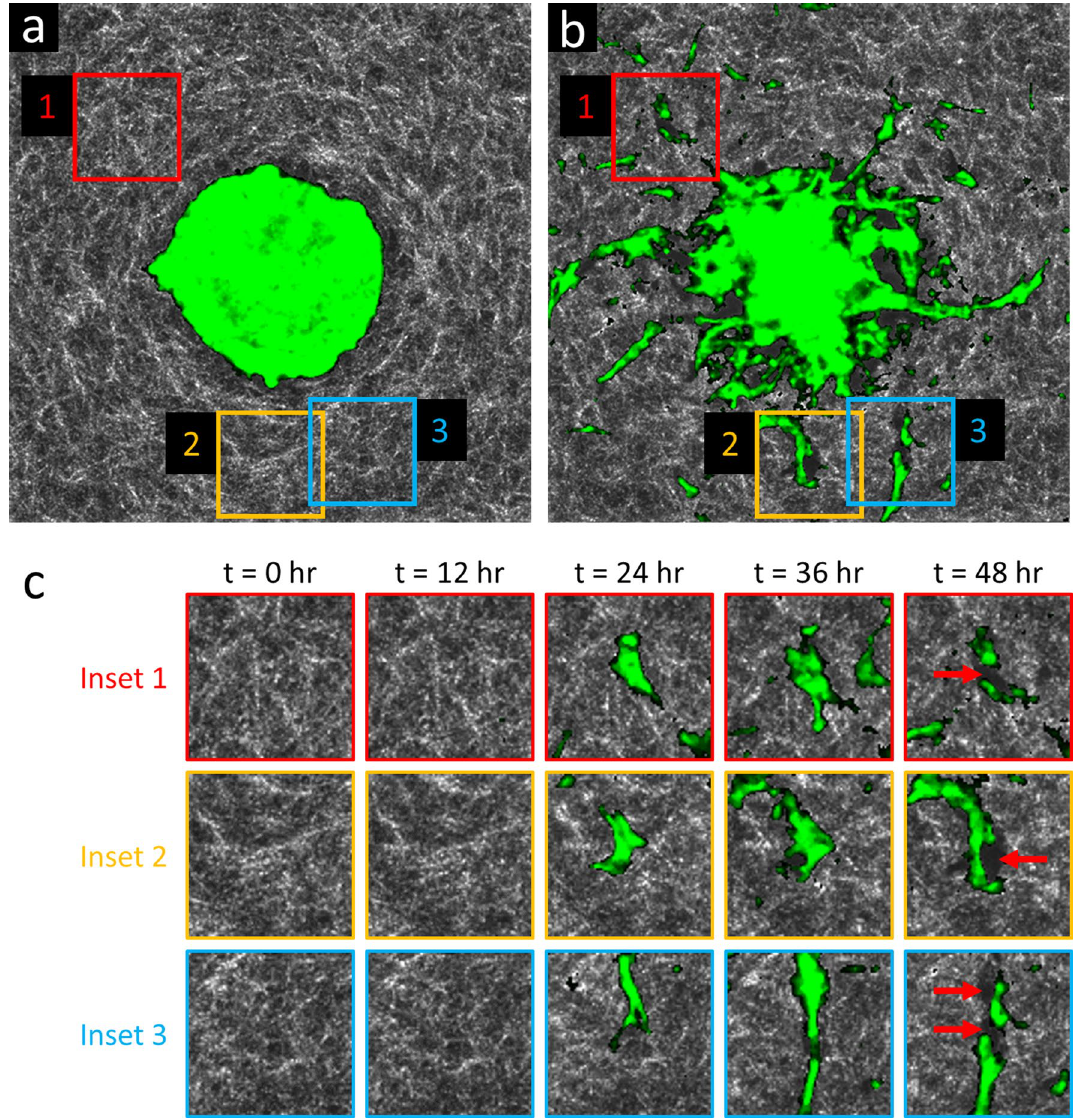
Figure 3. Time-lapse OCM imaging reveals collagen degradation by invasive cells and strands of cells. ( a ) En face plane intersecting the center (i.e., the ‘equator’) of a lean (WT) ASC monoculture spheroid, acquired at time t = 0 h. The spheroid (green, highlighted via temporal speckle contrast) is recently embedded, and has not yet invaded the surrounding collagen (white). ( b ) The same en face plane as in ( a ), acquired at time t = 48 h. Invasive protrusions are abundant. Large dark regions surrounding the spheroid and invasive strands correspond to ‘voids’ with low/weak scattering signals, suggesting a lack of either cells or collagen. ( c ) Time-lapse view of insets 1–3 from ( a , b ). Red arrows at time t = 48 h indicate newly formed ‘void’ regions where only collagen was initially present. These new ‘voids’ are likely due to degradation of the collagen matrix by invasive strands via matrix metalloproteinase activity. ( a , b ) span a 750 × 750 μm 2 lateral FOV. Time-lapse animation is available in Supplementary Video